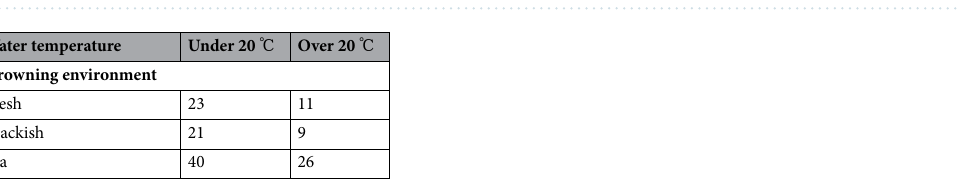
Figure 3. Comparing different parameters for both the drowning environment and postmortem interval (a) The weight of the lungs, (b) the weight of pleural effusion, (c) the ratio of pleural effusion.